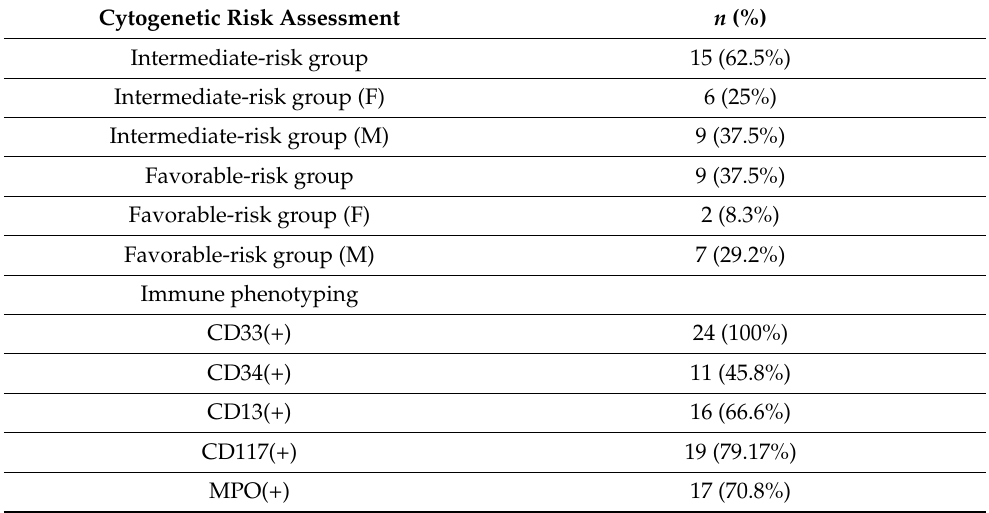
Table 5. Cytogenetic risk assessment and immune phenotyping.